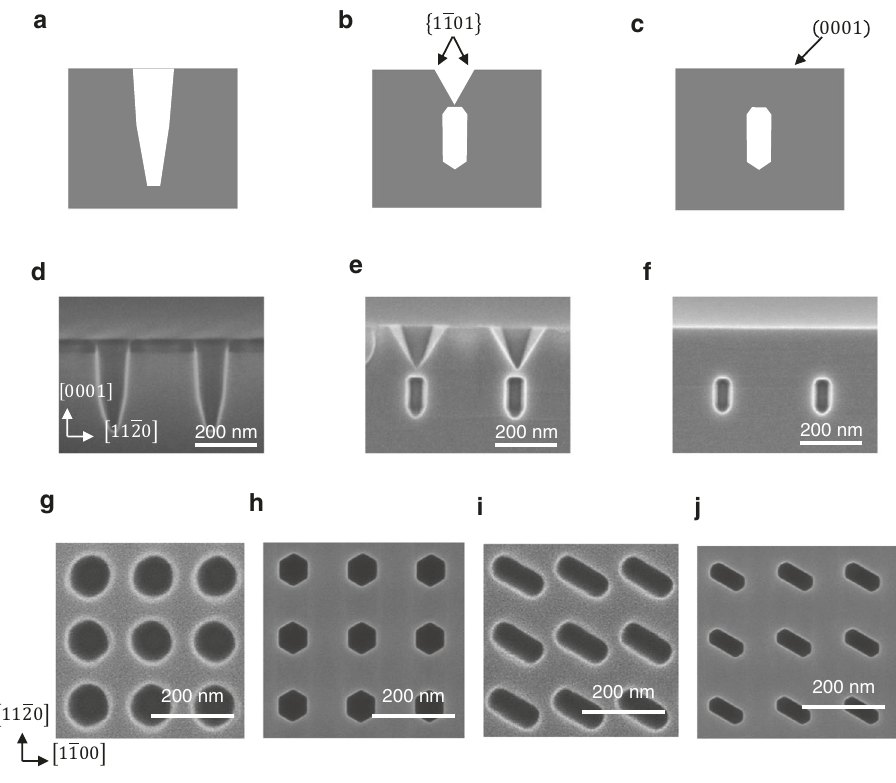
Fig. 2 Nano-fabrication methods of GaN/air photonic crystals. a – c Schematic of our nano-fabrication methods of GaN/air photonic crystals. d – f Cross- sectional SEM images of nano-fabrication methods of a GaN/air photonic crystal, corresponding to a – c . g A top-view SEM image of a photonic crystal with circular air holes after RIE. h A top-view SEM image of a photonic crystal after regrowth of g , observed by removing the top regrown GaN layer by FIB. i A top-view SEM image of a photonic crystal with elongated, asymmetric air holes along the <11 (cid:1) 20> direction after RIE. j A top-view SEM image of a photonic crystal after the regrowth of i , observed by removing the top regrown GaN layer by FIB.